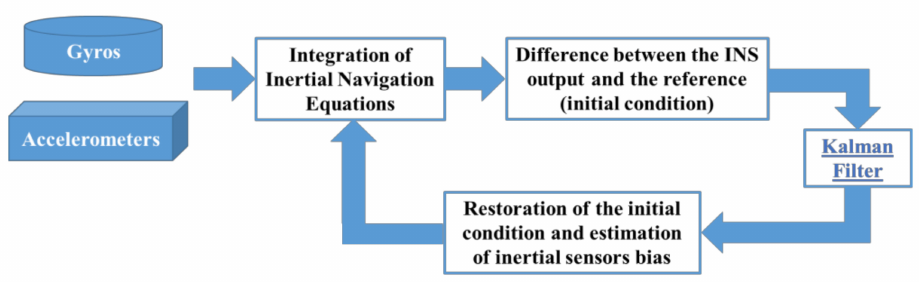
Figure 1. ZUPT filter block diagram